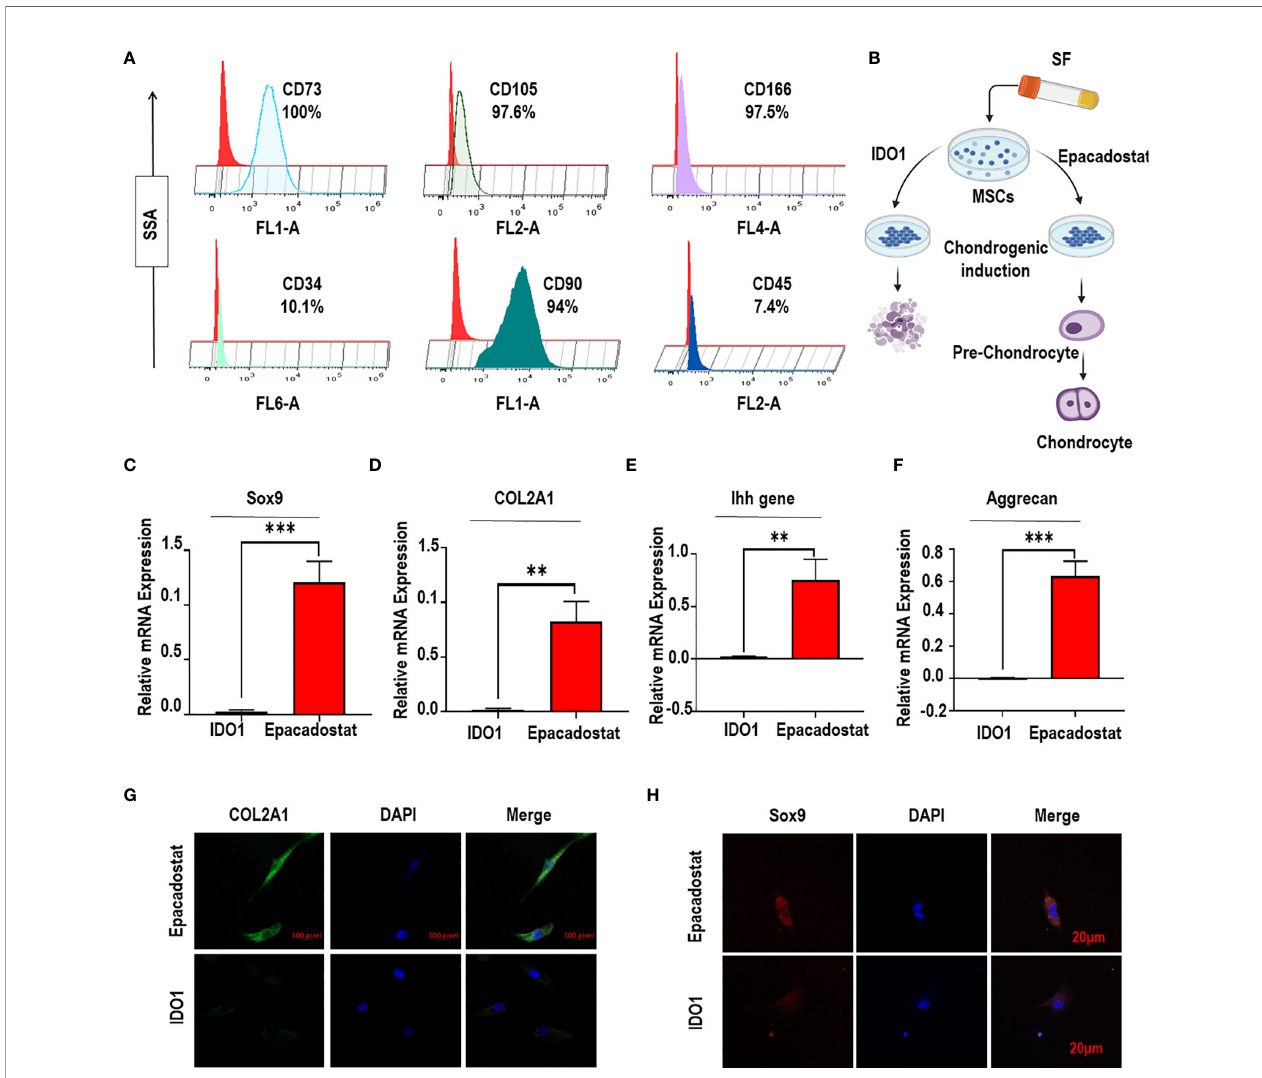
FIGURE 2 | IDO1 decreases the expression of chondrogenic genes in the stimulated MSCs. (A) Flow cytometry surface epitope pro fi ling of MSCs. (B) The effect of IDO1 compared to Epacadostat on the chondrogenic differentiation potency of MSCs. (C) The expression of Sox9 under the effect of IDO1 compared to Epacadostat. (D) The expression of COL2A1 under the effect of IDO1 compared to Epacadostat. (E) The expression of the Ihh gene under the effect of IDO1 compared to Epacadostat. (F) The expression of Aggrecan under the effect of IDO1 compared to Epacadostat. (G) The expression of COL2A1 under the effect Epacadostat using IF assay. (H) Epacadostat promotes Sox9 signaling compared to IDO1. *** p < 0.001 and ** p < 0.01 vs NC